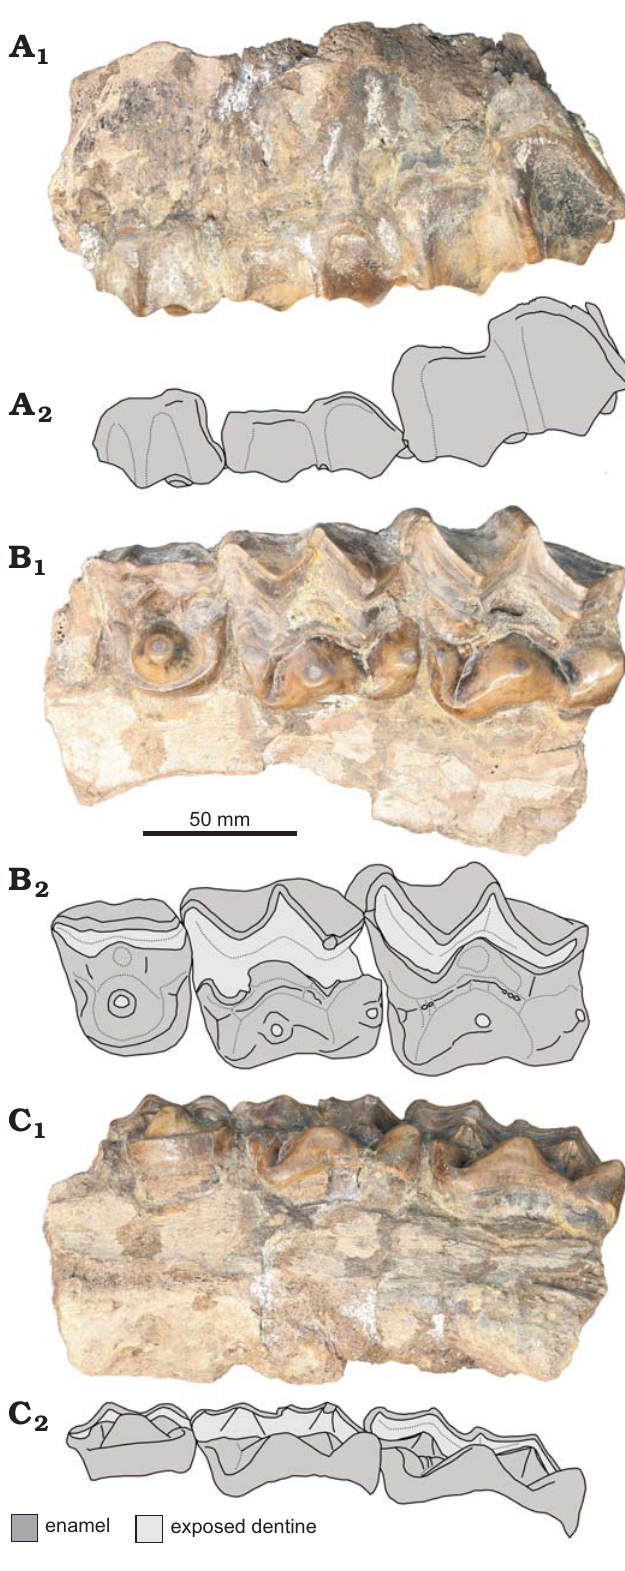
Fig. 2. Embolotheriit brontothere Maobrontops paganus gen. et sp. nov., SYSU-M-4 (holotype), from Maoming Basin, Guangdong Province, China; Youganwo Formation, upper Eocene. Left maxillary fragment with P4 and M1–2, in labial ( A ), occlusal ( B ), and lingual (C) views. Photographs (A 1 –C 1 ) and interpretive drawings of tooth crowns (A 2 –C 2